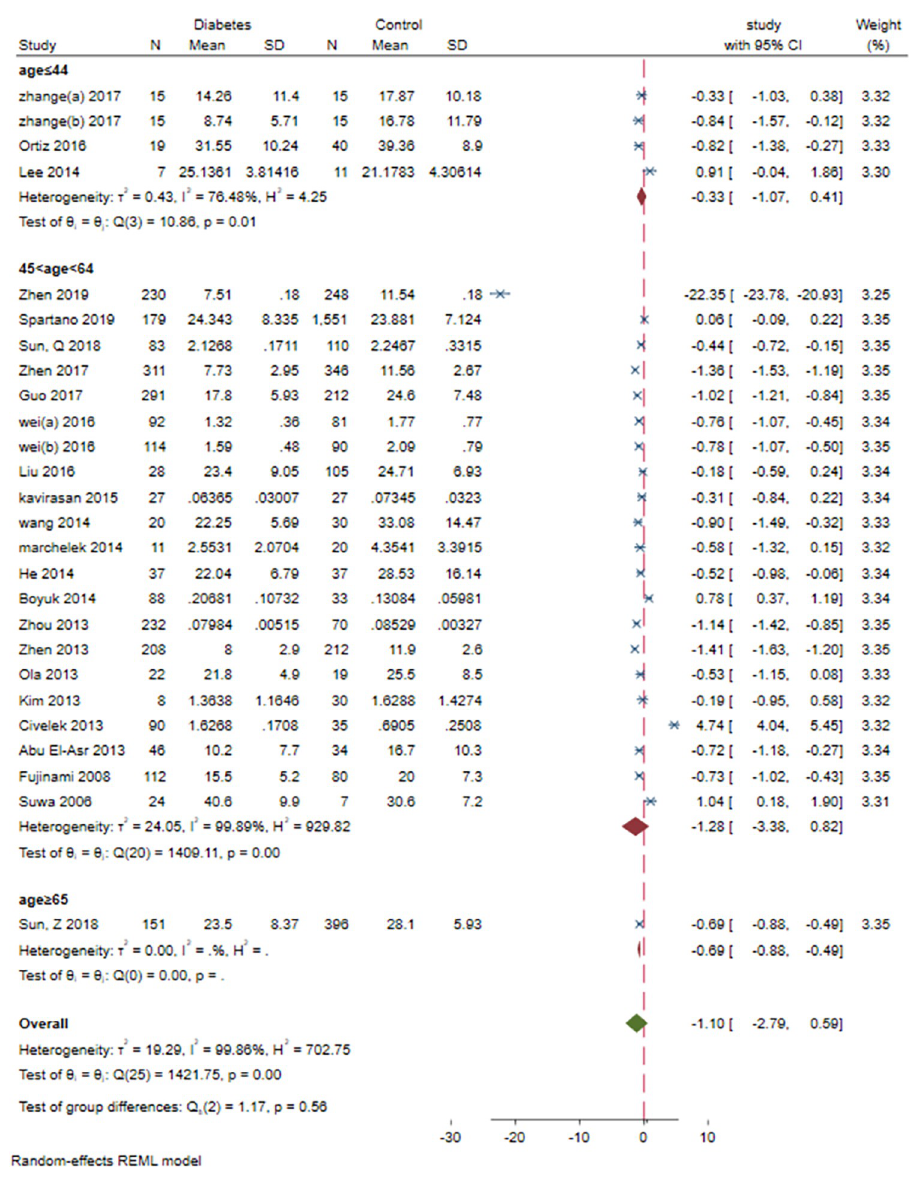
Fig 15. Subgroup meta-analysis of BDNF levels in patients with DM by